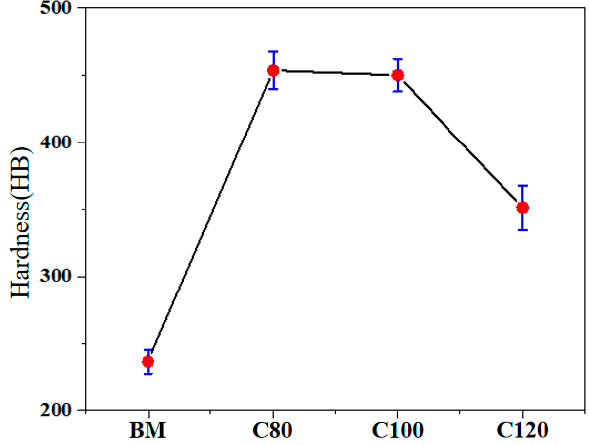
Figure 8. Surface hardness of the specimens treated with EBSA at different scanning speeds.